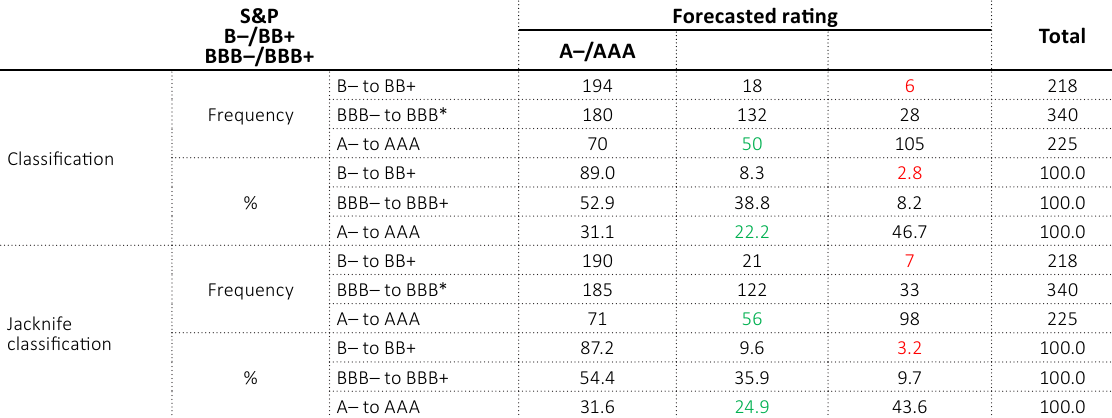
Table 14. Fisher’s discriminant functions